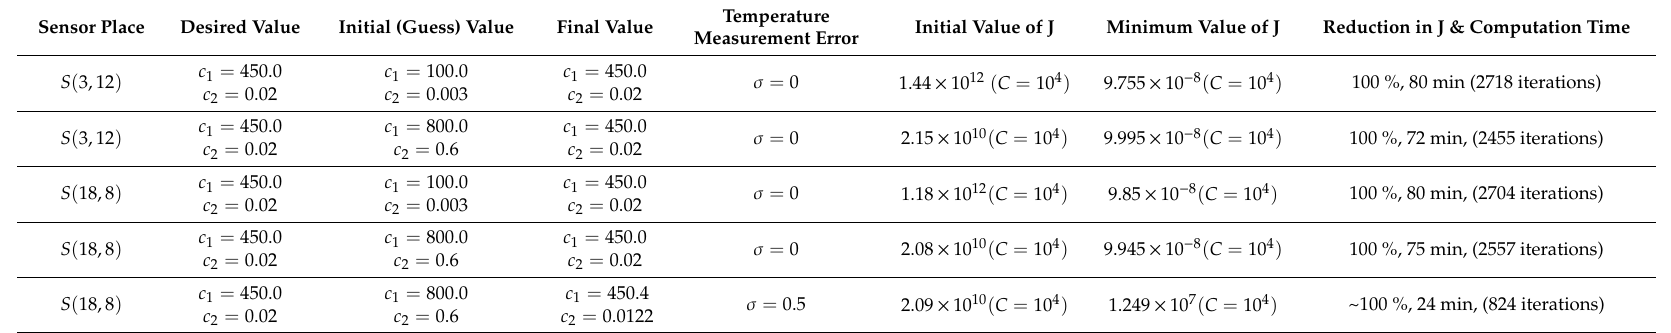
Table 2. A summary of results for the estimation of the temperature-dependent specific heat components c 1 and c 2 ( c = c 1 + c 2 T ).